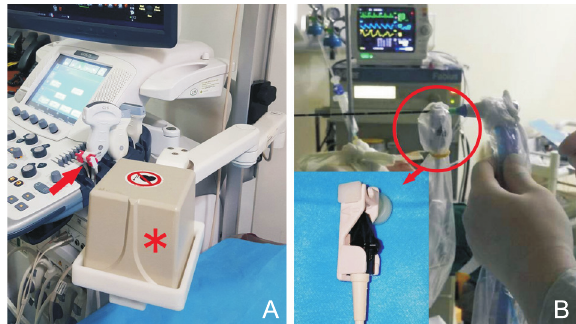
Figure 2 A, “*”was a magnetism generator and the red arrow was pointing the magnetic sensor on the transducer. B, the red arrow was pointing the needle-tracking device.